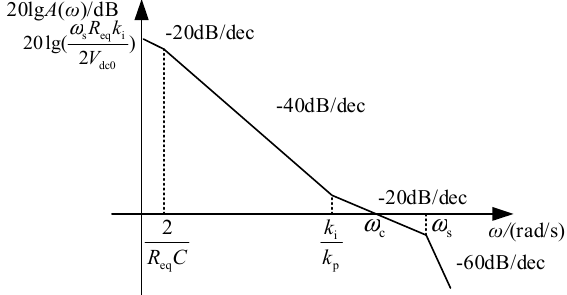
Figure 12. The amplitude–frequency characteristic curve of the DC bus voltage control loop transfer function.